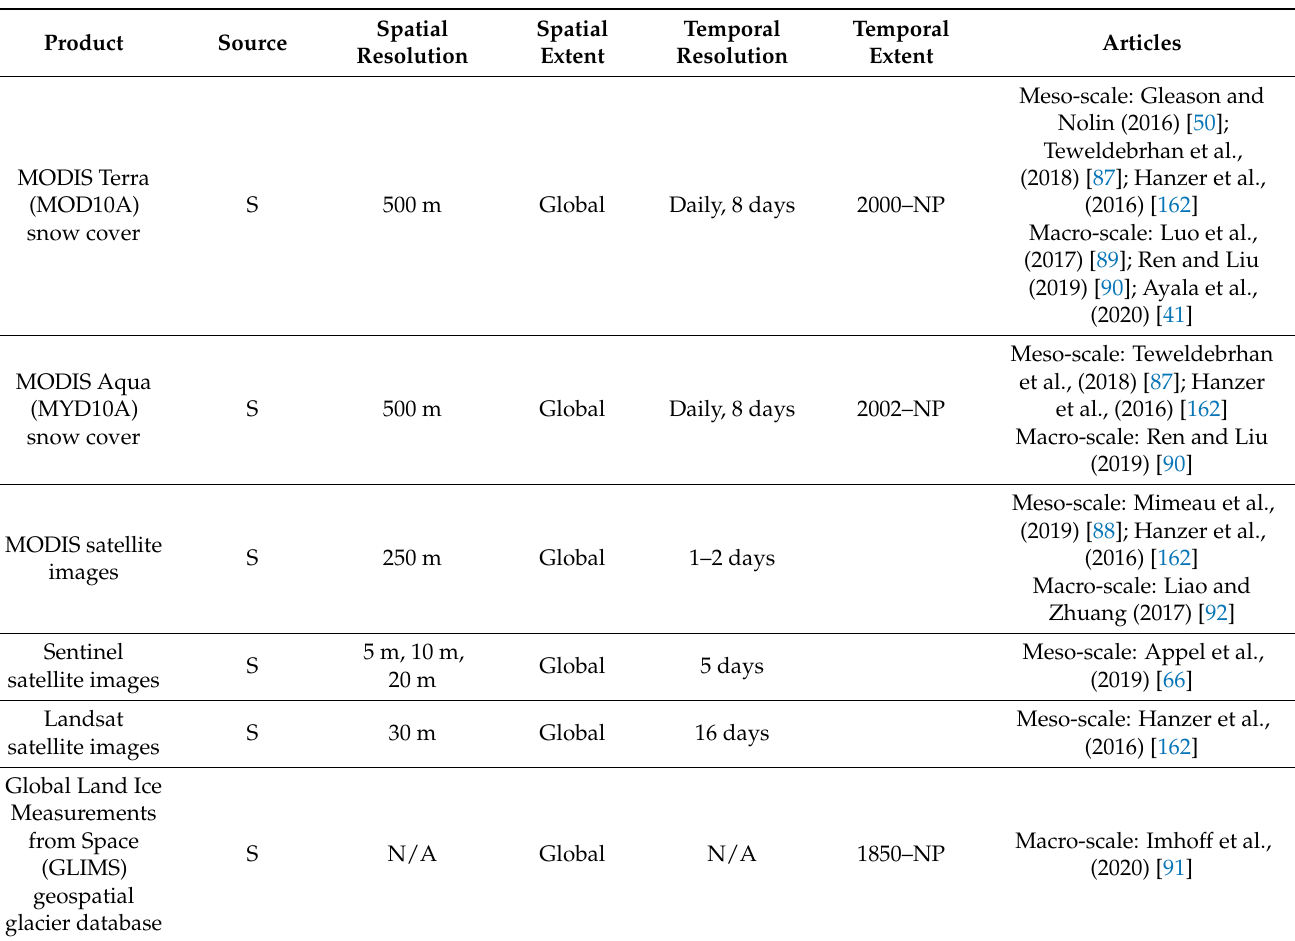
Table A6. Snow-Covered Area (SCA) products used in reviewed